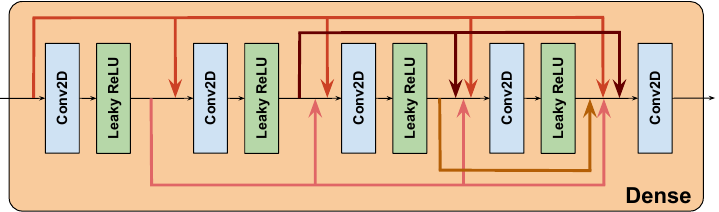
Figure 3. Dense Block. A RRDB is composed of three dense blocks scaled by Xb and combined, as depicted in Figure